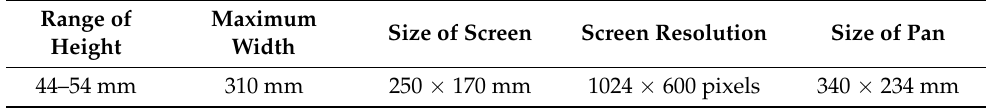
Table 2. Mechanical Specifications of the ISSVS.